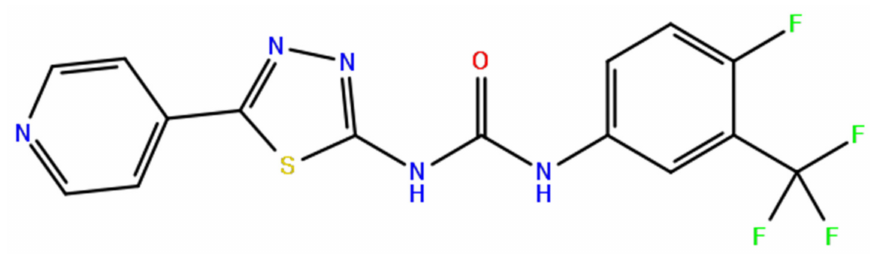
Figure 11. ML216, the known inhibitor of BLM and WRN